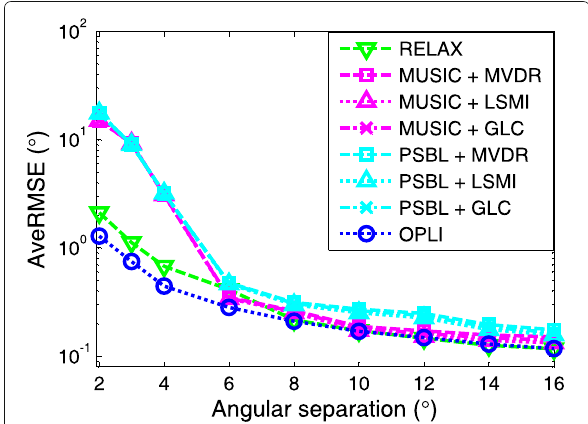
Fig. 9 AveRMSE versus angular separation